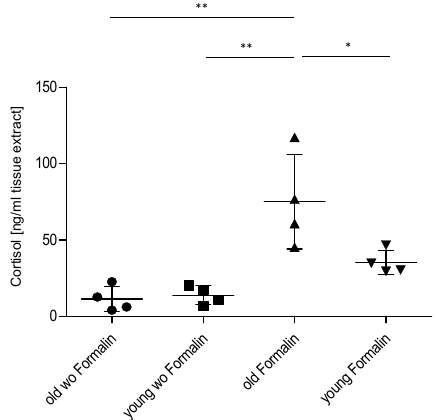
Figure 4. Effect of age on spinal cortisol levels in mice with/without nociceptive stimulation. Cortisol levels in young and old mice at basal level and 45 min after injection of formalin into the hind paw, as assessed by cortisol ELISA ( n = 4/group). wo = without formalin, * p < 0.05, ** p < 0.01, statistically significant difference.